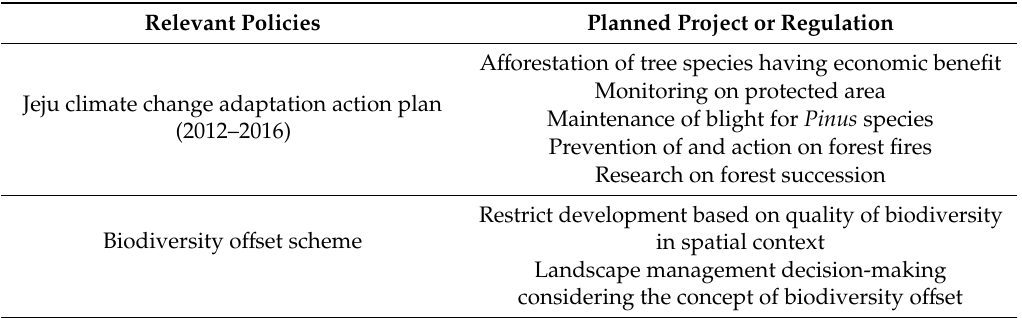
Table 5. Relevant polices in Jeju municipalities regarding climate change and biodiversity conservation. Only directly related policies for vegetation management or restriction of development area were